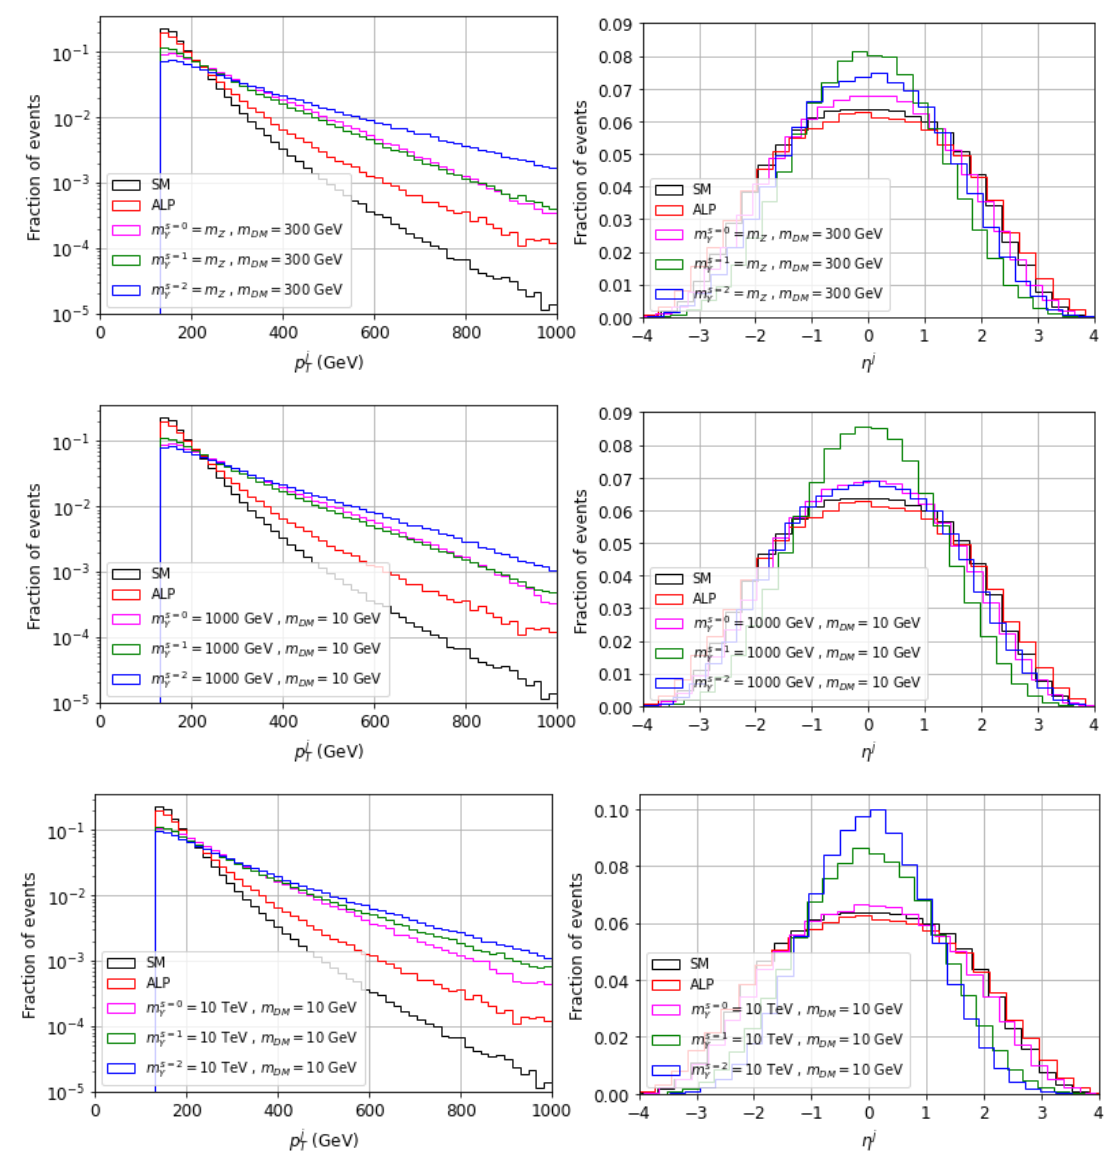
and η j distribution for the benchmark models shown in Table 1. Off-shell Figure 4: p j T (top row), on-shell (middle row), and off-shell PS (bottom row) regimes, at detector